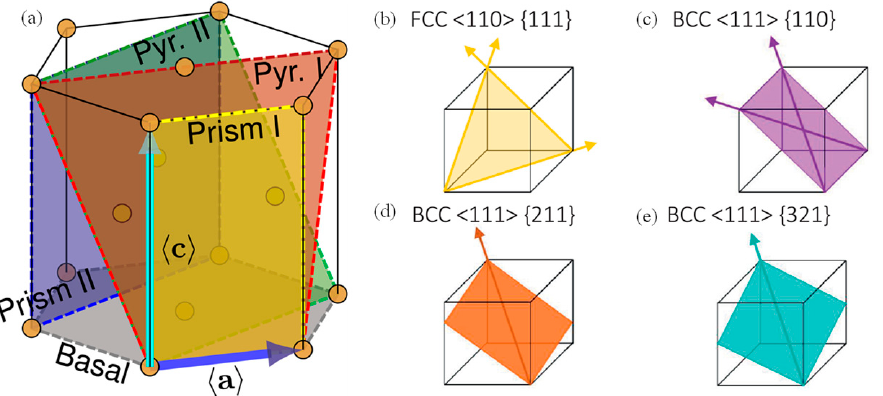
Figure 24. Slip system: ( a ) HCP metals [139]. Reproduced with permission from Elsevier Ltd. ( b ) FCC slip systems; ( c – e ) BCC slip systems [140]. Reproduced with permission from Elsevier Ltd.